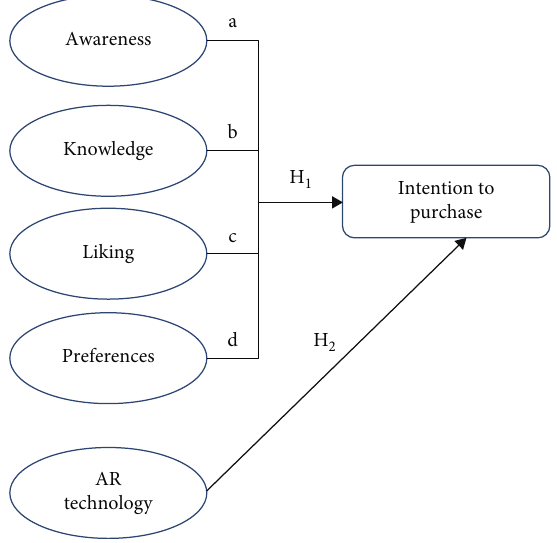
Figure 3: Research conceptual